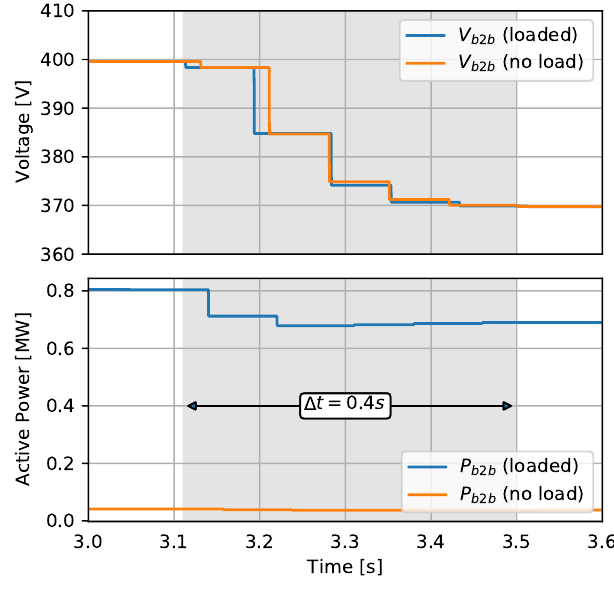
Figure 10. Open-loop B2B